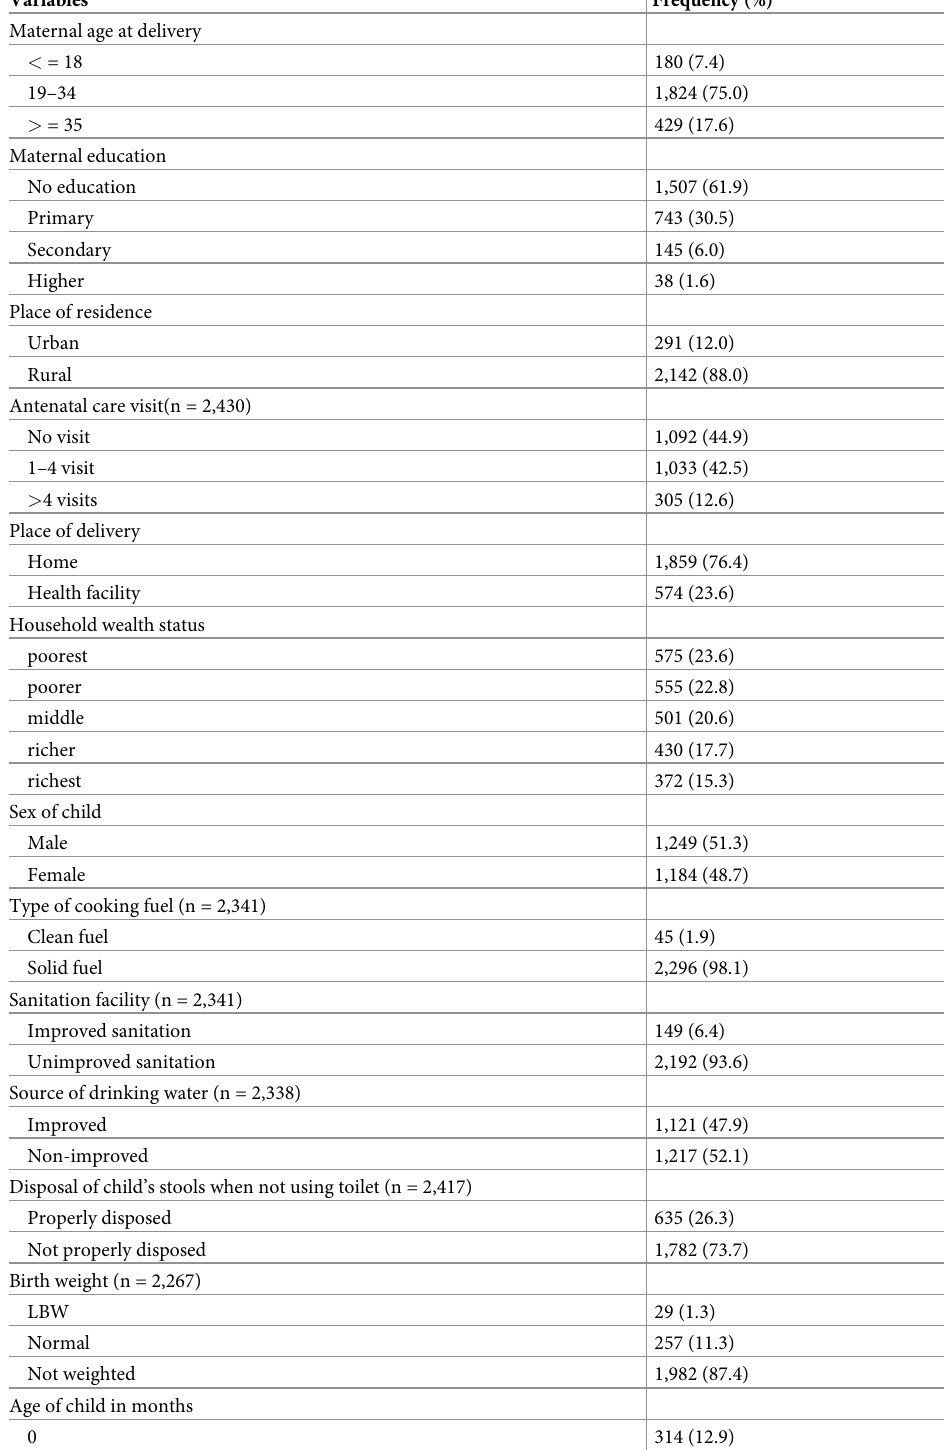
Table 1. Sociodemographic characteristics of mothers and children and household facilities, 2011 and 2016 EDHS,